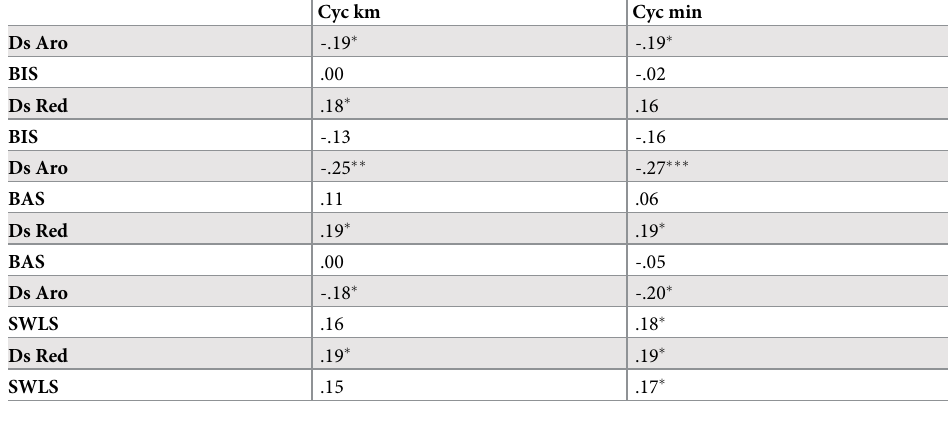
SWLS .16 .18 � Ds Red .19 � .19 � SWLS .15 .17 � Note . � p < .10